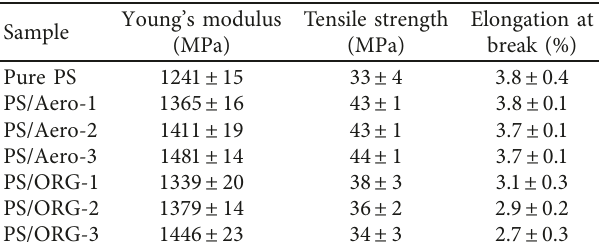
Figure 8: Transparency images of PS/clay nanocomposites pre- pared from the nanoclay aerogel masterbatch and organoclay. Table 5: Tensile properties of PS/clay nanocomposites prepared from the nanoclay aerogel masterbatch and